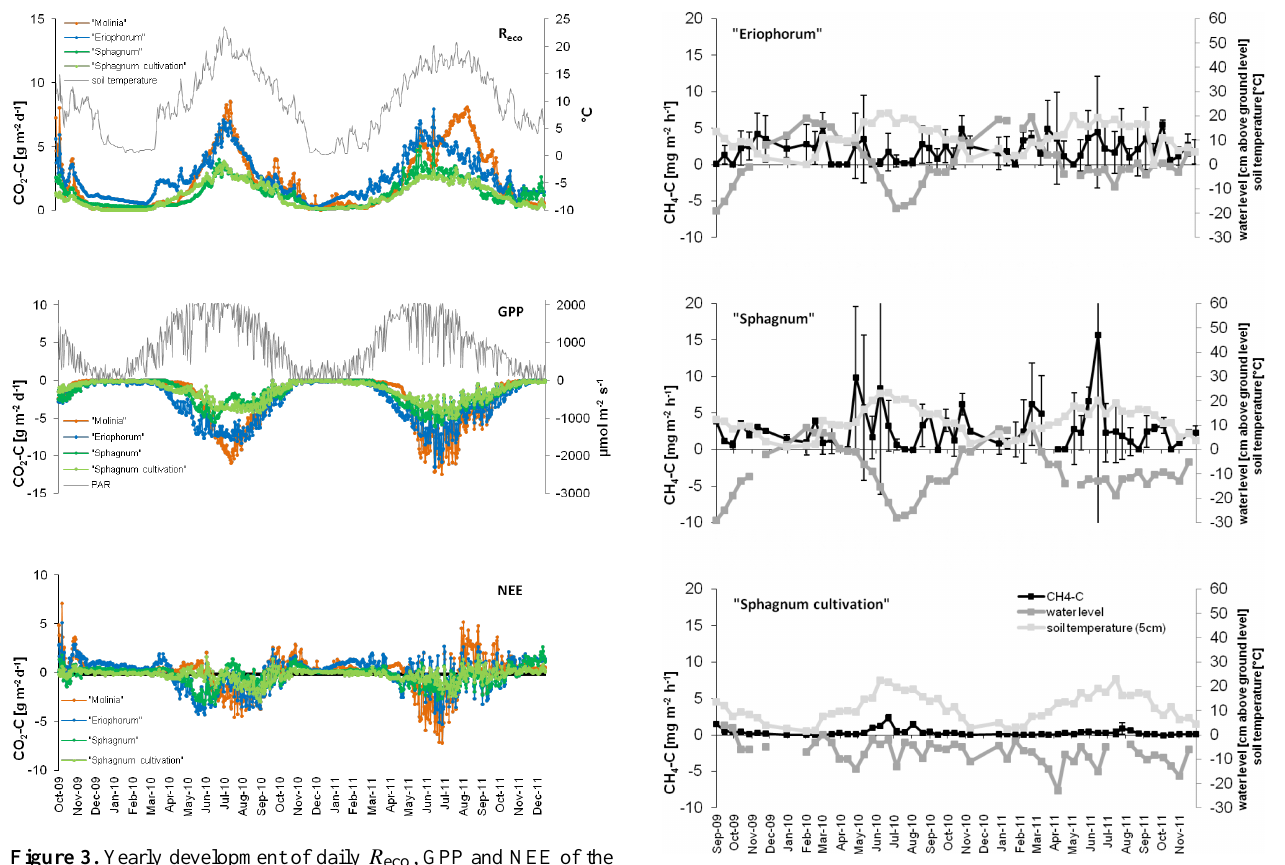
Figure 4. Yearly development of CH 4 flux at “ Eriophorum ”, “ Sphagnum ” and “ Sphagnum cultivation” (left axis). Mean of the three collars; error bars are standard errors. Yearly development of water level and soil temperature at a depth of 5cm (right